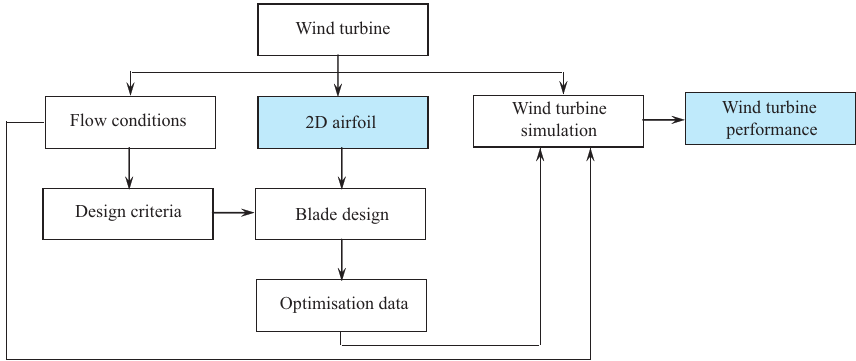
Figure 1. Flow diagram of the modelling of wind